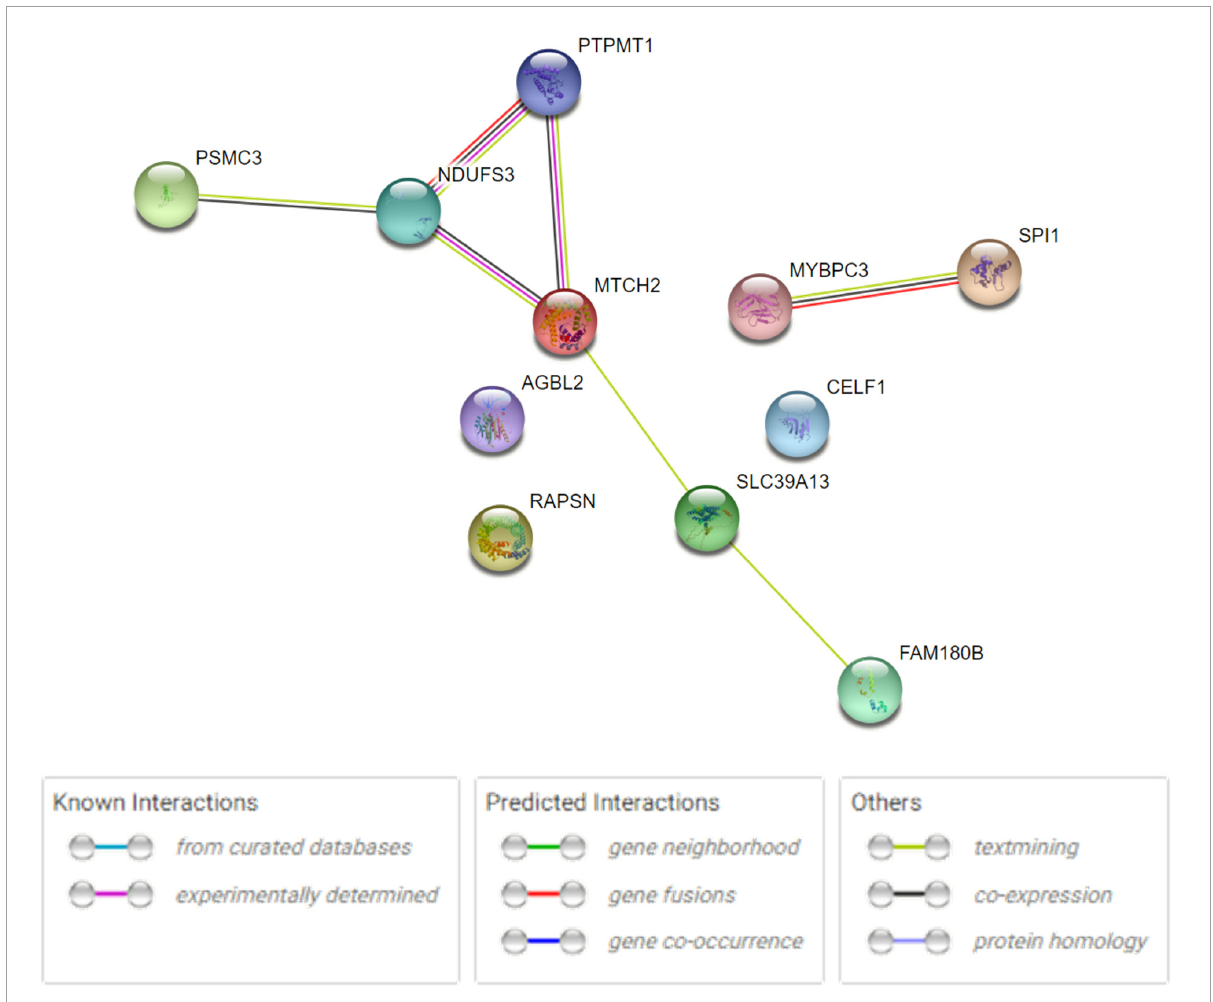
FIGURE3 Human PPI network analysis for 11 shared genes between AD and glaucoma. PPI network connectivity for proteins identified in both AD and glaucoma. PPI results are based on the experimental evidence with the String database (https://string-db.org) (version 11.5). Network nodes represent proteins produced by the protein-coding gene loci. Edges between nodes indicate protein–protein interactions. The network contains 11 nodes with 7